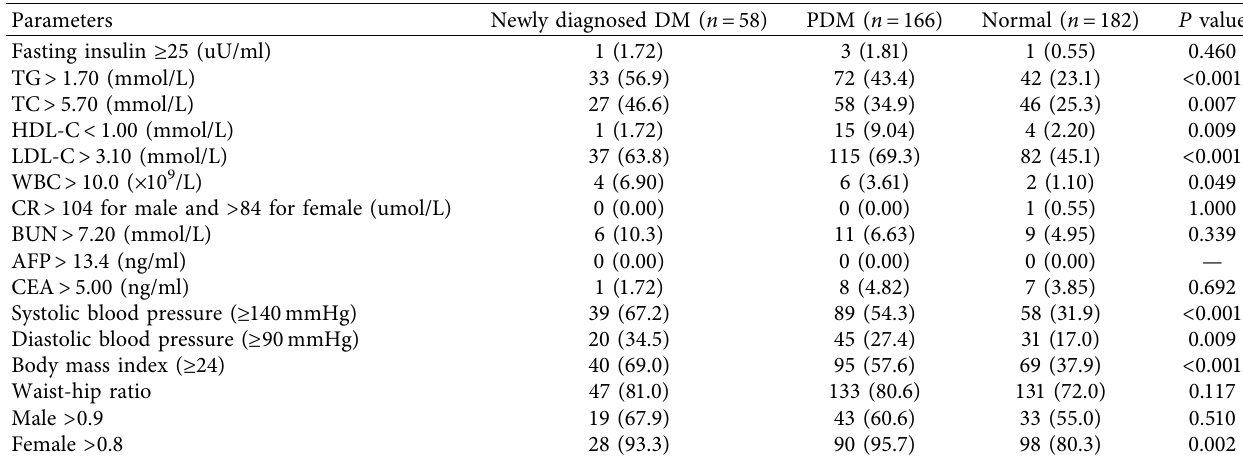
Table 3: Baseline biochemical and anthropometric measurements of study participants ∗